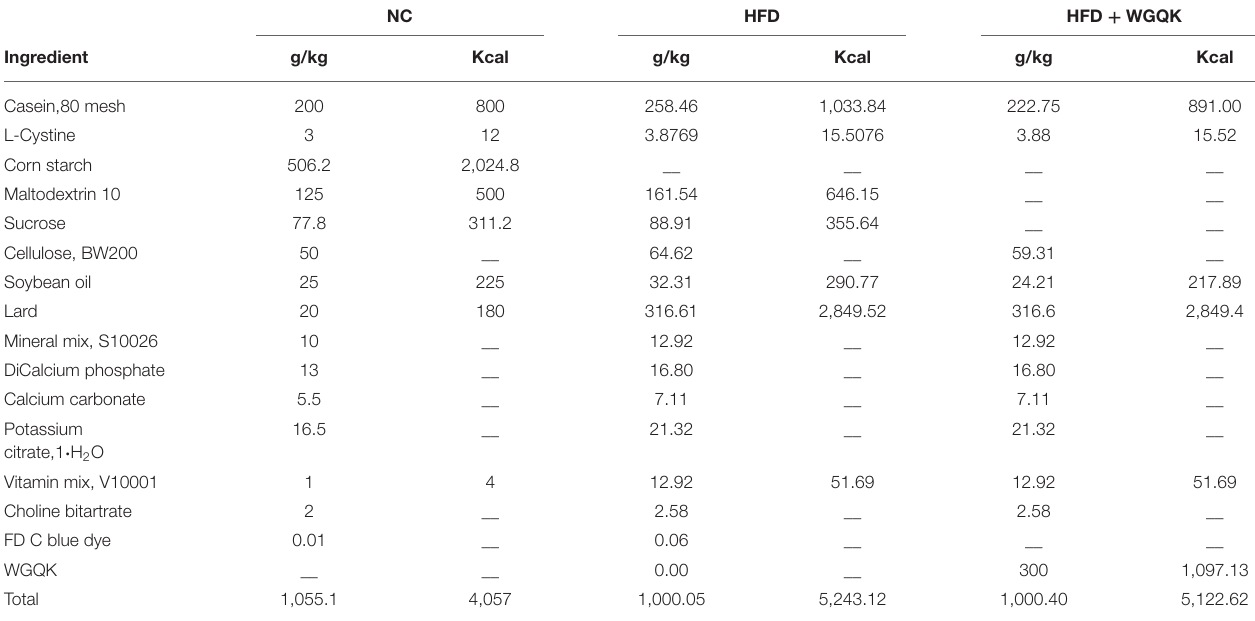
TABLE 1 | Composition of experimental